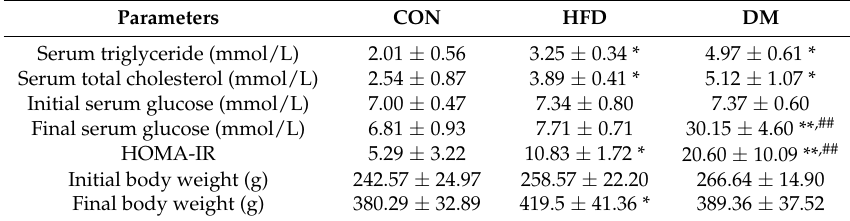
Table 1. Biochemical parameters and alterations in experimental rats.